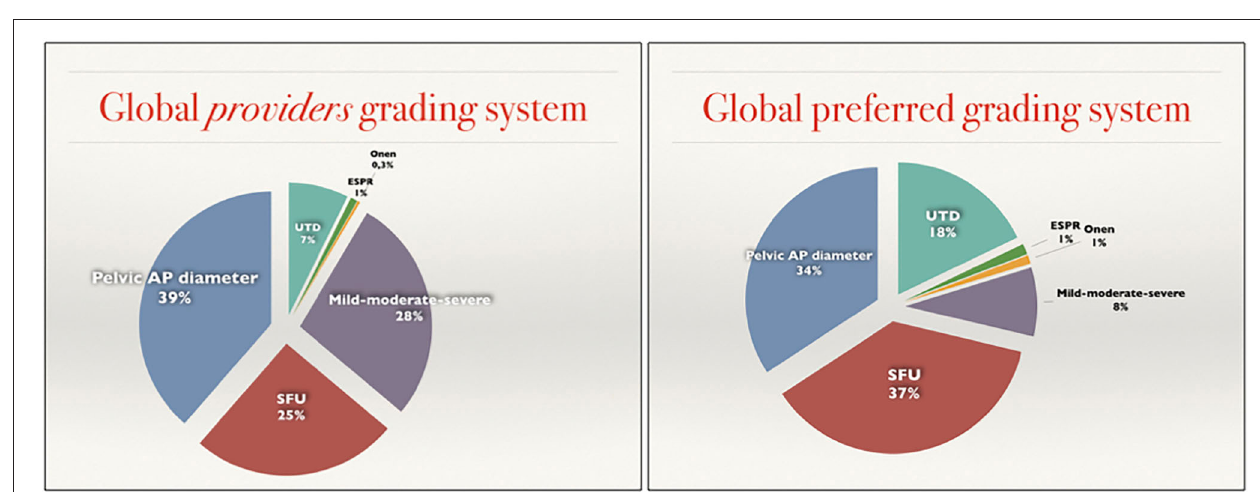
FIGURE 2 | Graphic representation of the differences between Grading systems provided and Grading systems preferred.